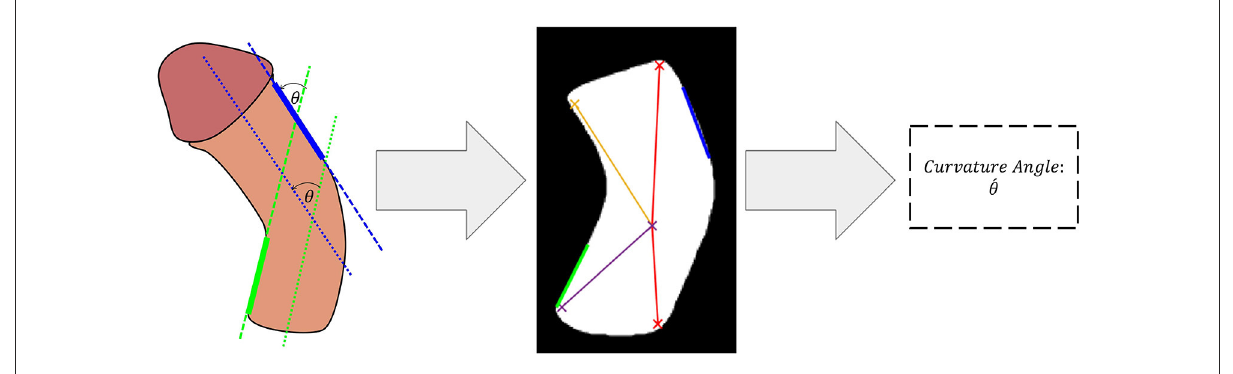
FIGURE3 Lines selection method for estimation of curvature